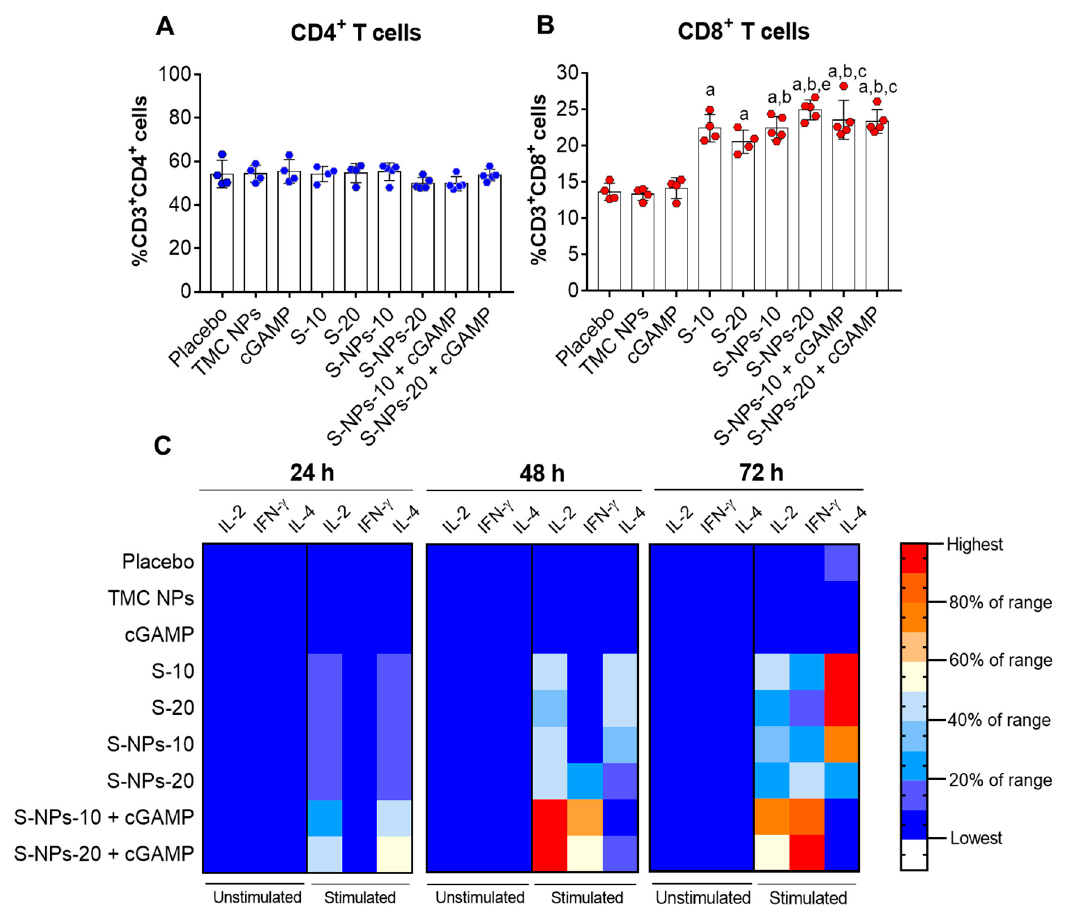
Figure 6. Systemic T cell responses. Splenocytes from immunized mice on day 45 were isolated and restimulated with S-protein (10 µ g/mL). After 72 h post-treatment, splenocytes were harvested and subjected to measuring the percentages of CD4 + ( A ) and CD8 + ( B ) T cells by flow cytometry. Results are mean ± SD. ( C ) Heat map representing splenic cytokine profiles (IL-2, IFN- γ , and IL-4) from culture supernatant at three consecutive days (24, 48, and 72 h of treatment). “a” indicates significant differences between S-containing vaccines and placebo group. “b” indicates significant differences of S-NPs or S-NPs + cGAMP compared with TMC NPs. “c” indicates significant differences between S-NPs + cGAMP and cGAMP adjuvant. “e” indicates significant differences between soluble S-protein and S-NPs at 20 μ g/dose ( p < 0.05).